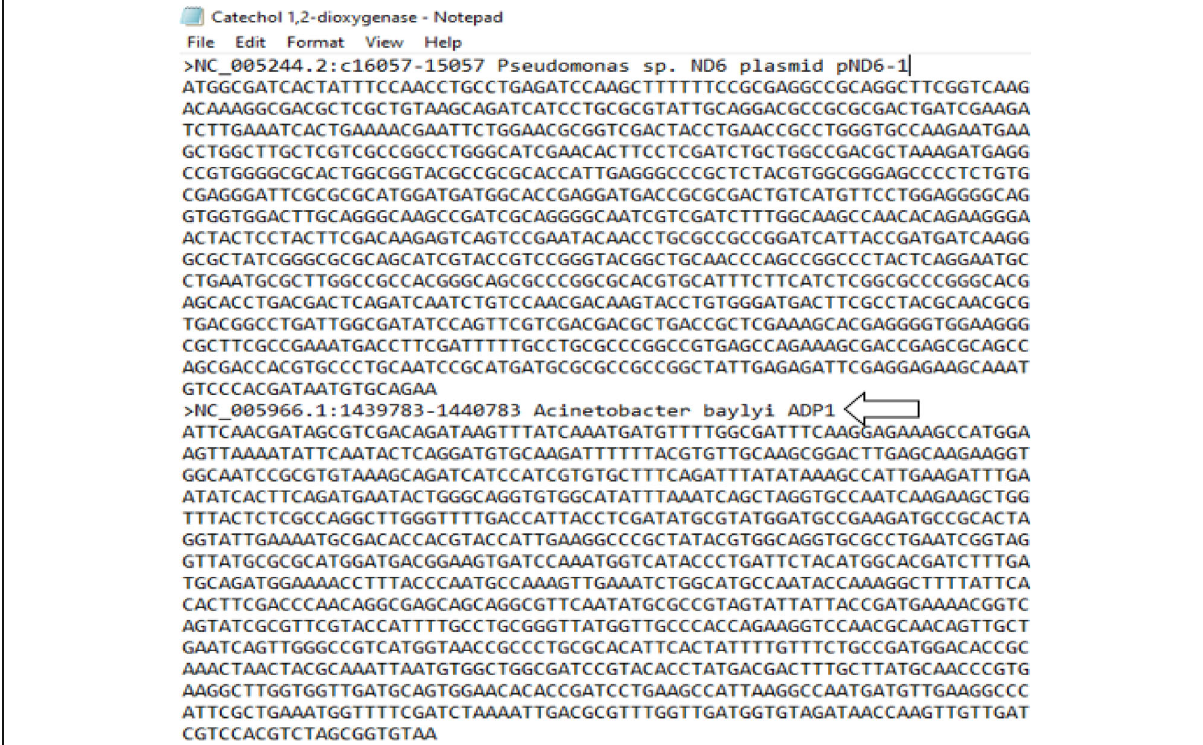
Fig. 3 Graphical representation of sequence organization for degenerate primer design. The arrow shows the FASTA identity representation. “ > ” depicts the FASTA command for a new sequence. NC_005966, 1439783-1440783, Pseudomonas sp , ND6 represent the accession number, region of the sequence retrieved, bacterial name, and strain